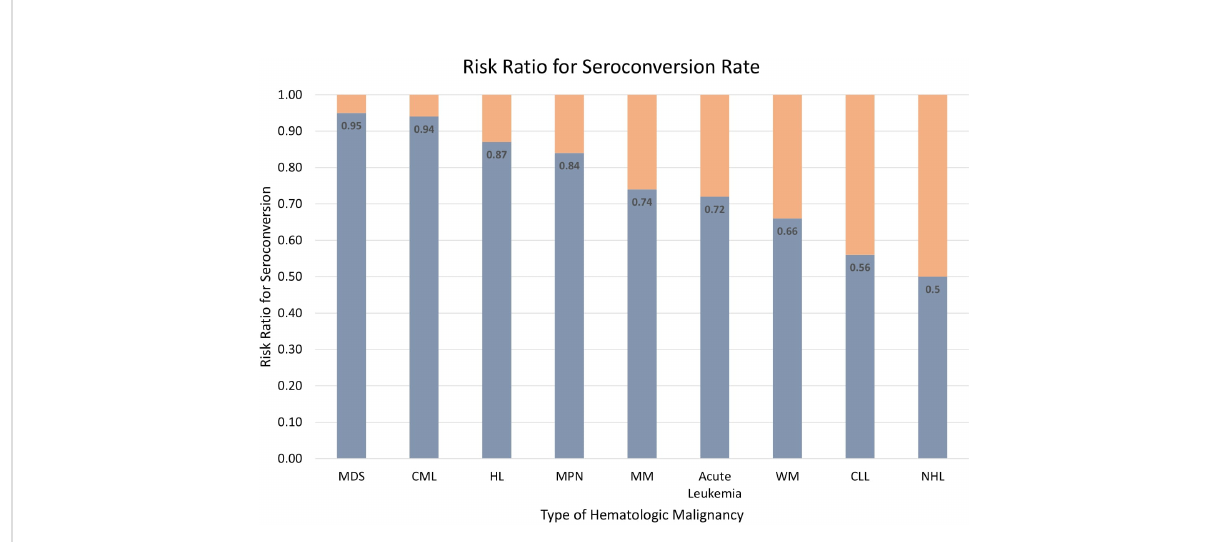
FIGURE 4 Risk ratio for seroconversion among different types of hematological malignancies.